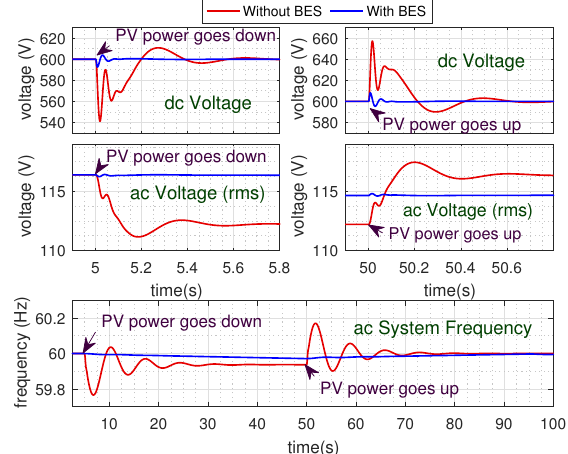
Figure 14. Voltage and frequency due to the abrupt PV